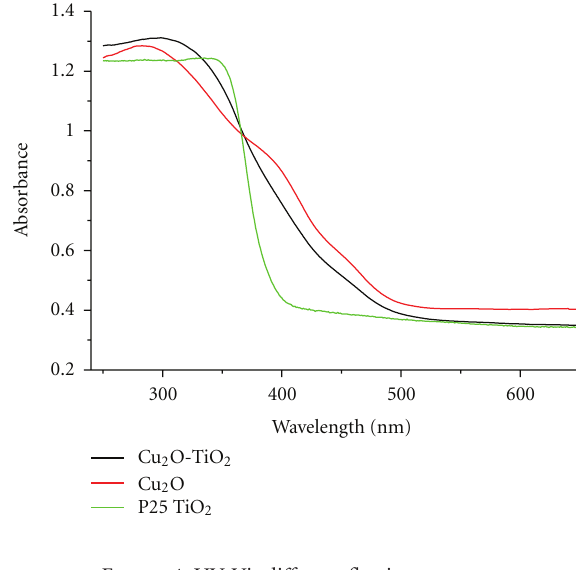
Figure 4: UV-Vis di ff use reflection spectra.